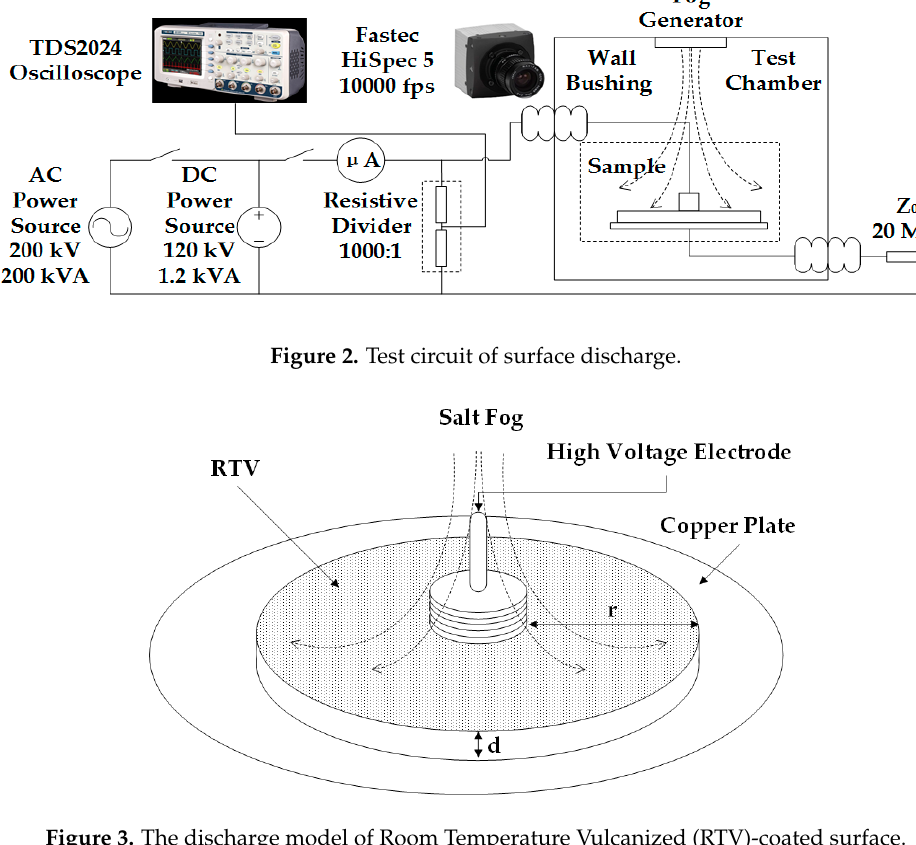
Figure 2. Test circuit of surface discharge .